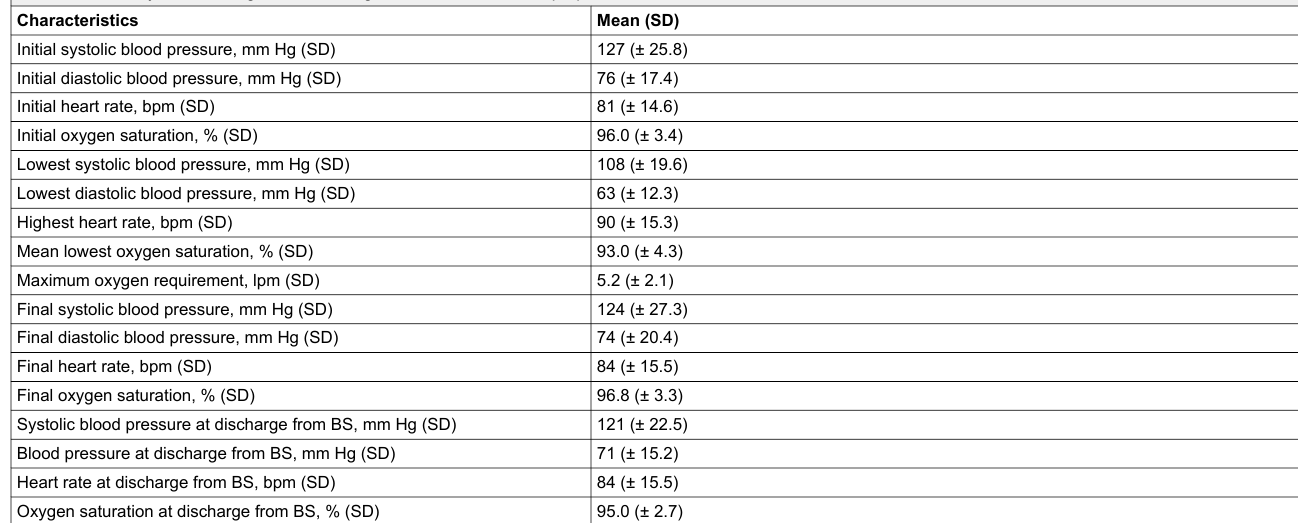
Table 4: Haemodynamic findings before, during and after sedation with propofol.